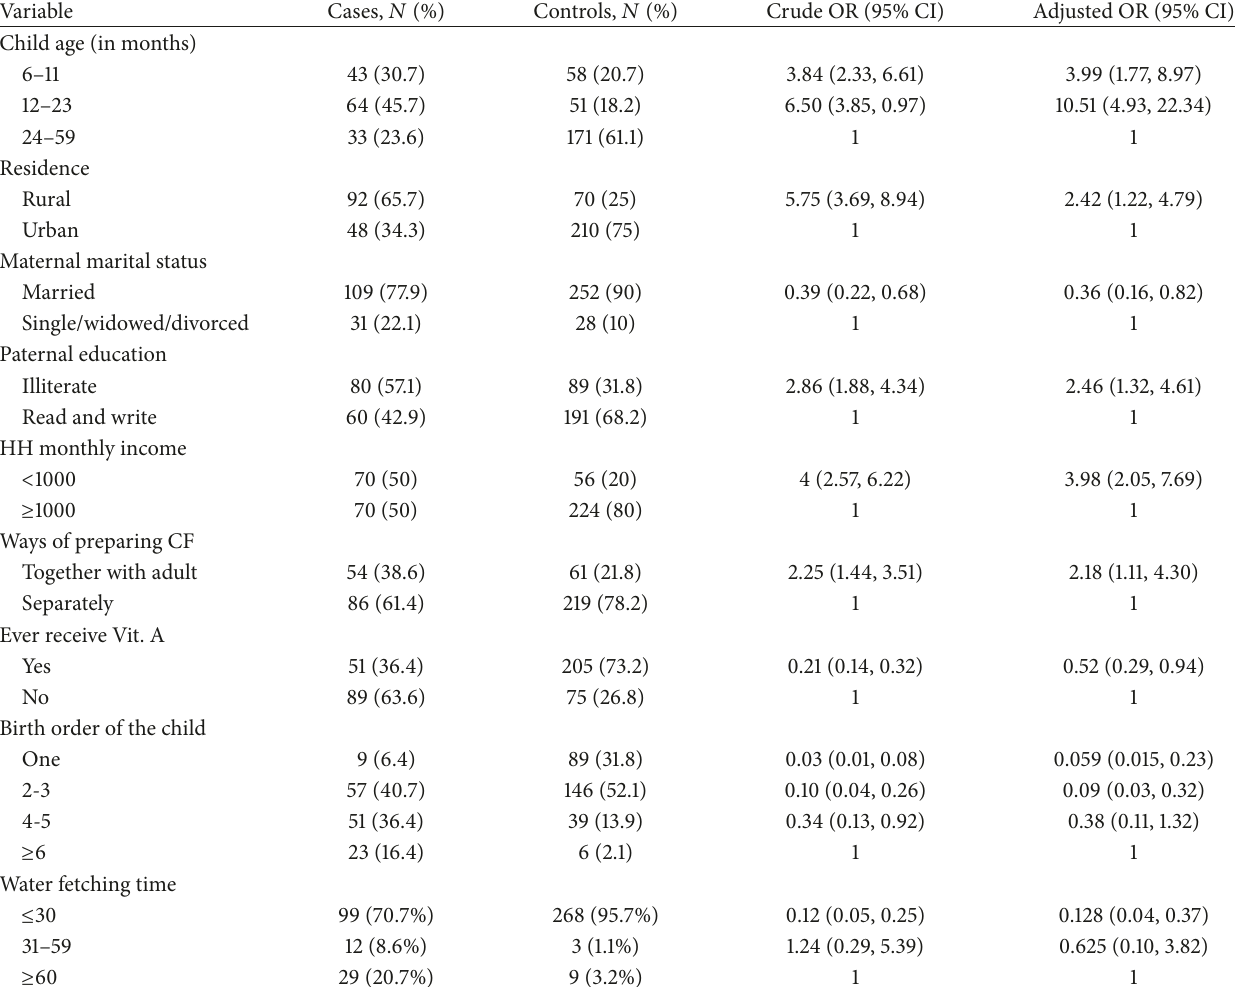
Table 5: Determinant factors of acute malnutrition among children aged between 6 and 59 months from Dubti District, Afar Regional State, Northeast Ethiopia, January 2014 (cases: 𝑁 = 140 and controls: 𝑁 = 280